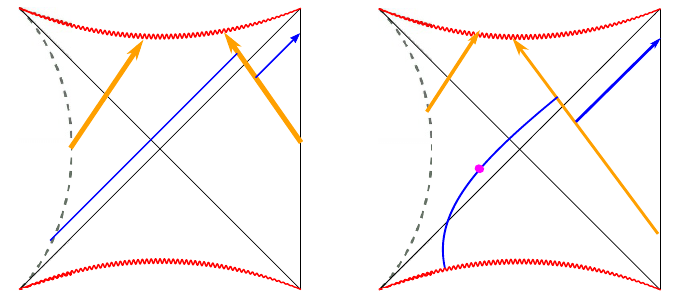
Figure 8 . Two variants of Experiment